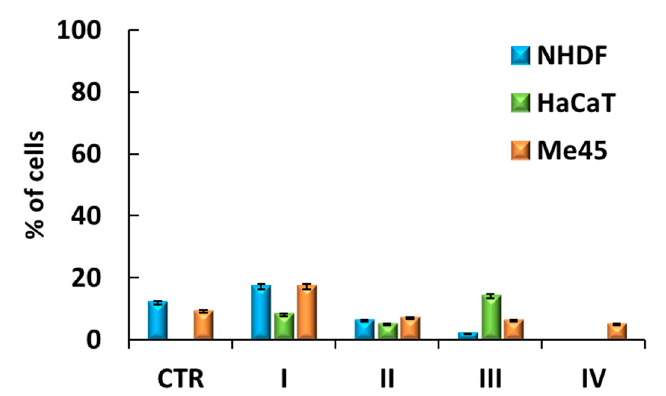
Figure 9. Senescence in cells after a 72 h incubation with a solution containing system III (100 μ